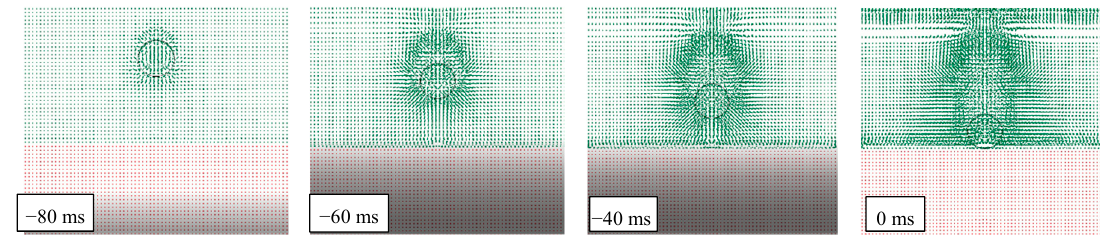
Figure 3. FEM-SPH model used for simulating the air effect during the free fall (drop height of 1500 mm).